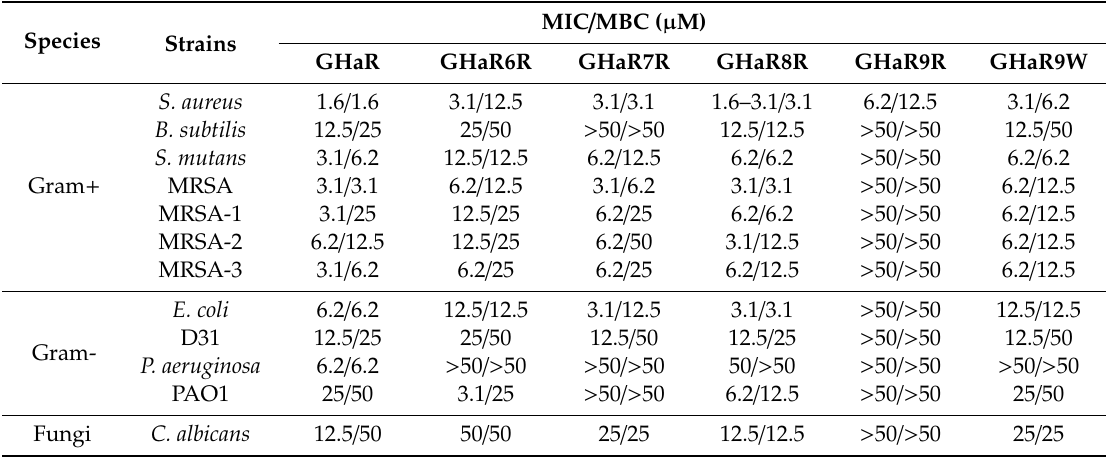
Table 2. MICs and MBCs of GHaR and the derived peptides on tested strains.